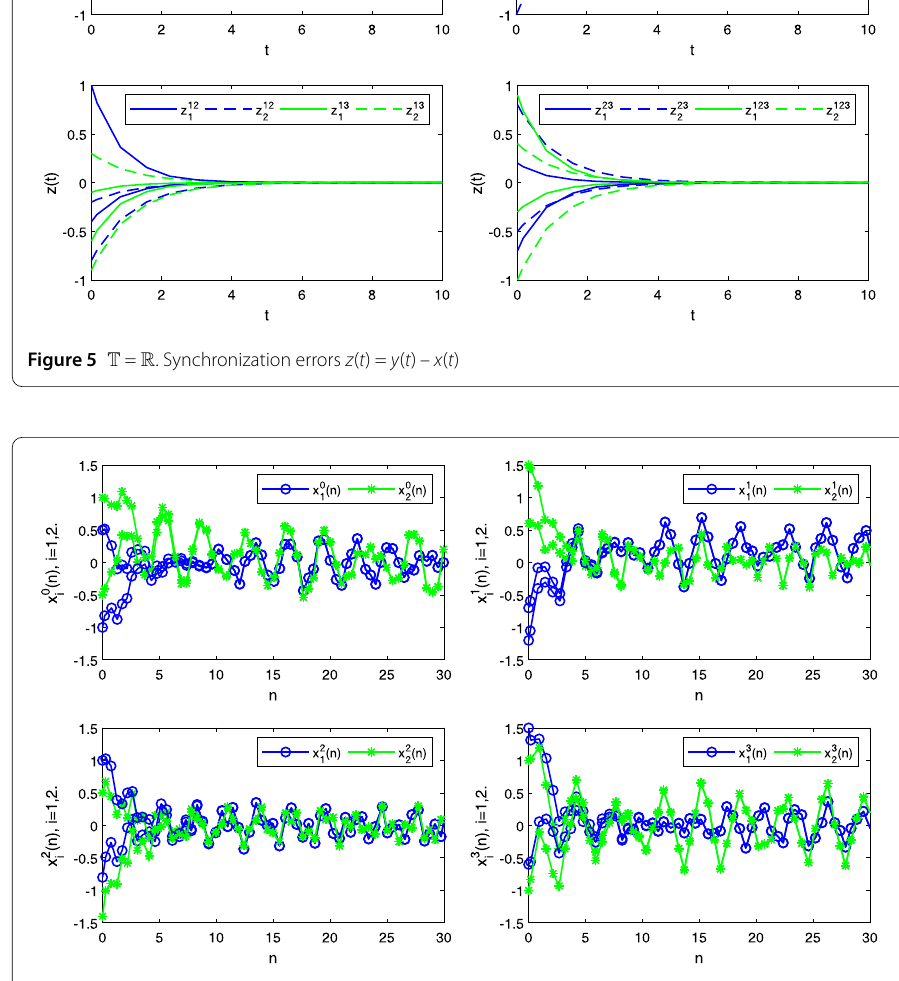
Figure 6 T = Z . Transient states of x 0 ( n ), x 1 ( n ), x 2 ( n ) and x 3 ( n )